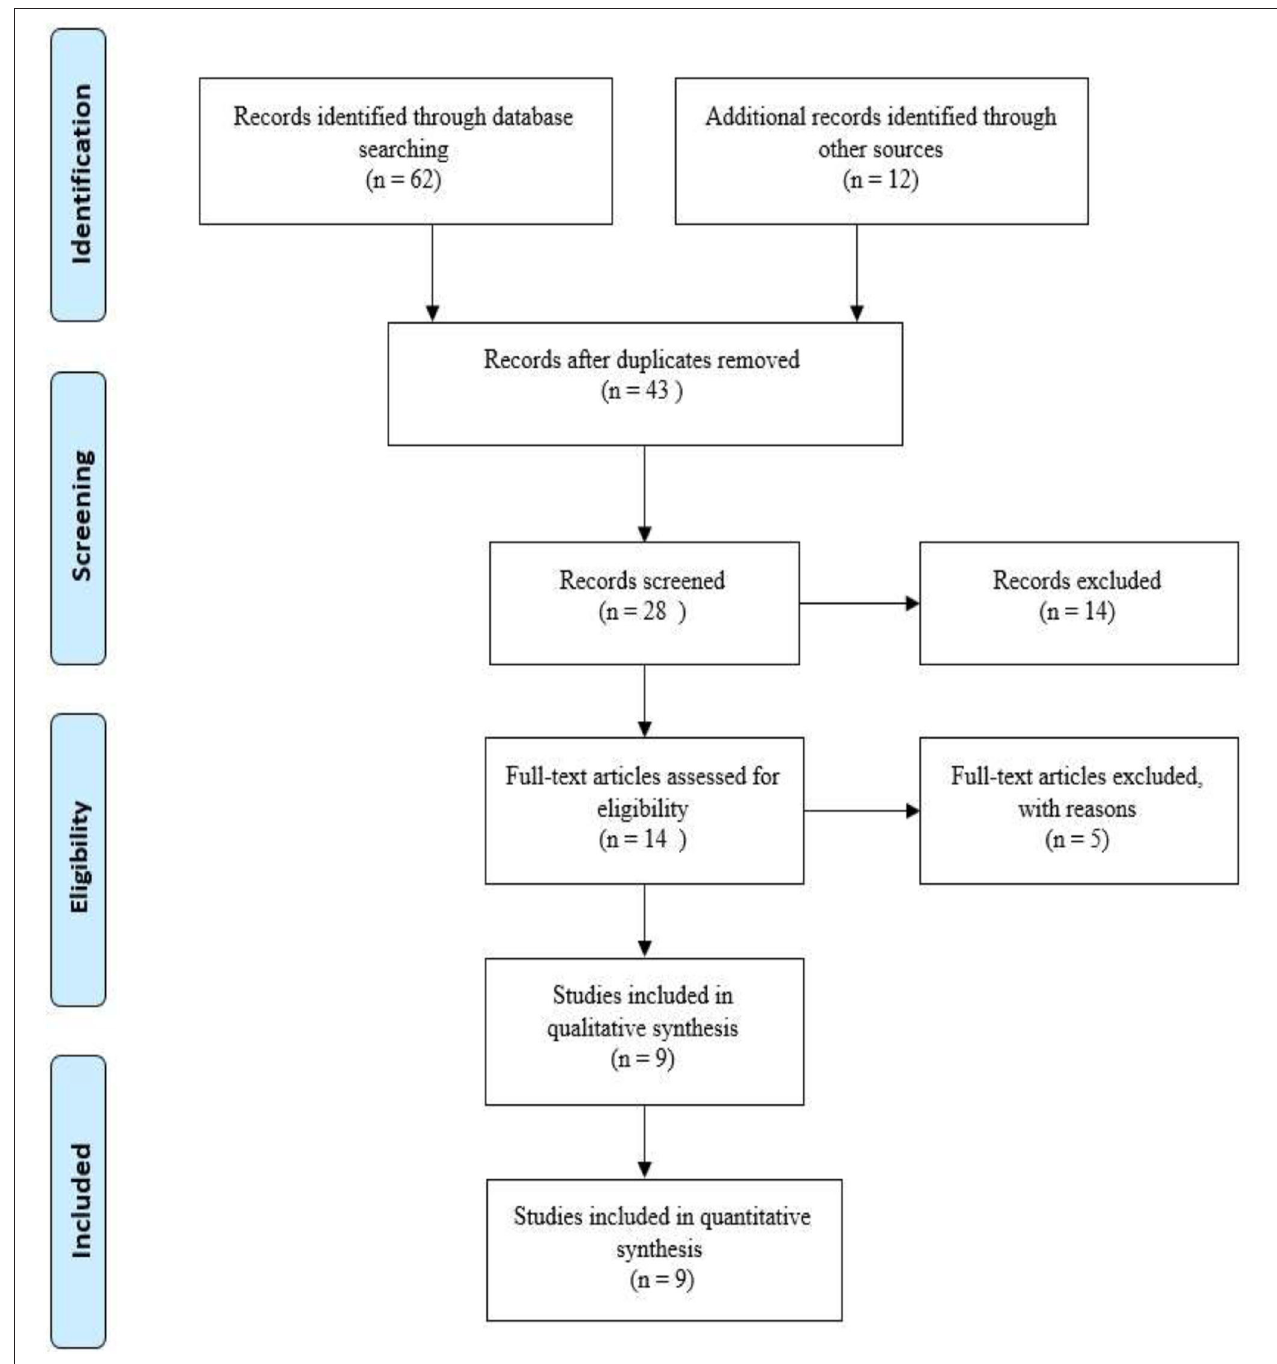
FIGURE 1 | Representation of the search strategy based on PRISMA flow diagram.